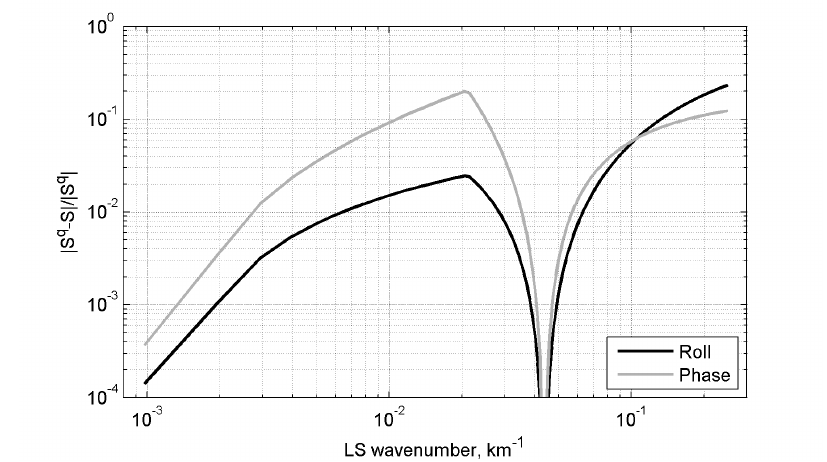
Figure 2. Relative errors in approximating the LS power spectra for various GOE components at 2 km resolution. Timing and dilation curves coincide with the phase curve due to exact similarity of the respective spectra shown by gray lines in Figure